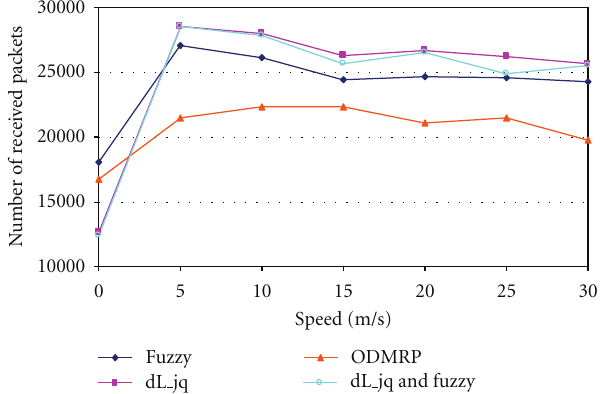
Figure 9: Number of received packets with increasing speeds of